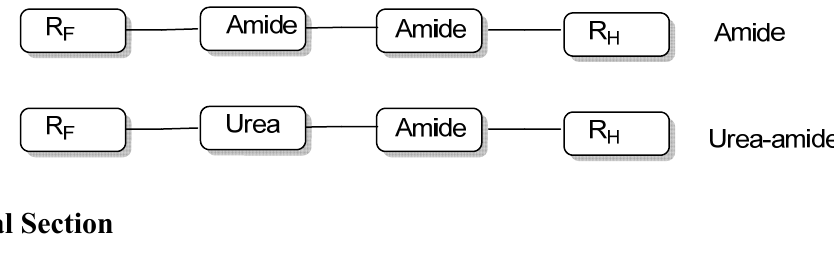
Figure 2. General structure of partially fluorinated amide and urea-amide derivatives described in this